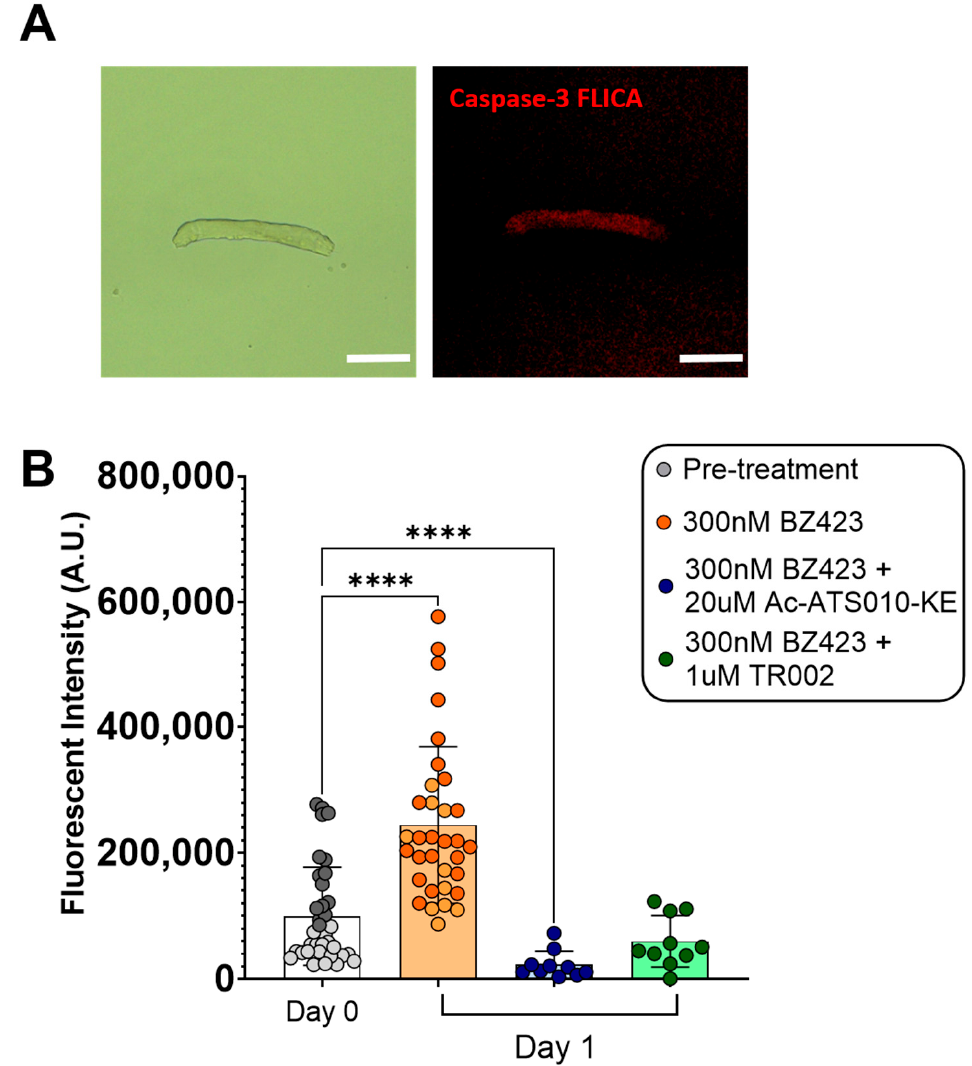
Figure 3. To examine the impact of chemical induction of MPT on caspase-3 activation, single isolated myofibers were treated with either 300 nM Bz423, 300 nM BZ423 + 20 µ M Ac-ATS010-KE (to inhibit caspase-3), or 300 nM BZ423 + 1 µ M TR002 (to inhibit MPT) for 24 h, and caspase-3 FLICA signal was determined at baseline and post-treatment. ( A ) Representative brightfield and fluorescence images of single FDB muscle fibers following 24 h treatment with Bz423. Scale bars represent 100 µ m. ( B ) While TR002 prevented an increase in caspase-3 FLICA fluorescence over the 24 h treatment period, Ac-ATS010-KE decreased signal compared to Day 0. Treatment with BZ423 induced an increase in caspase-3 FLICA, indicating an increase in caspase-3 activity following treatment. Biological replicates are identified by data points of different colors within a given treatment, while technical replicates share the same color data point. n = 2 biological replicates were used for pre-treatment and 300 nM Bz423-treated myofibers, while n = 1 biological replicate was used for all other groups. **** p < 0.0001 versus Day 0.